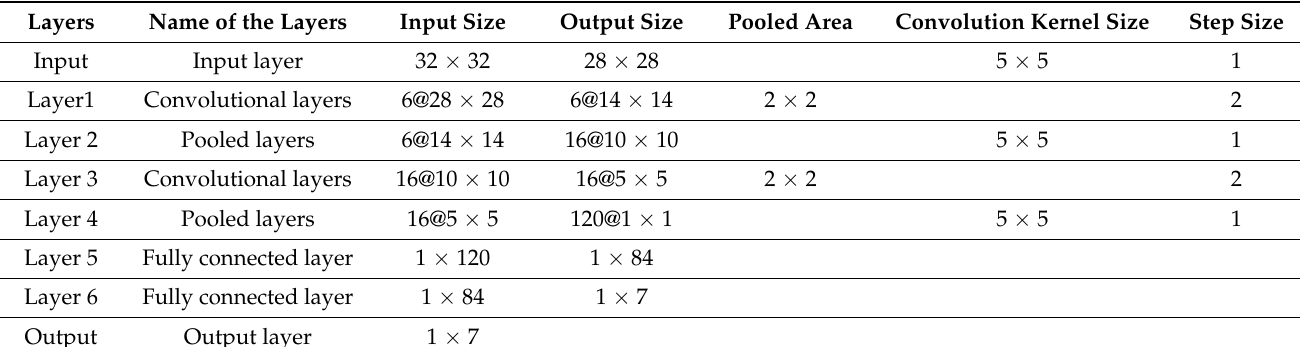
Table 1. LeNet-5 detection